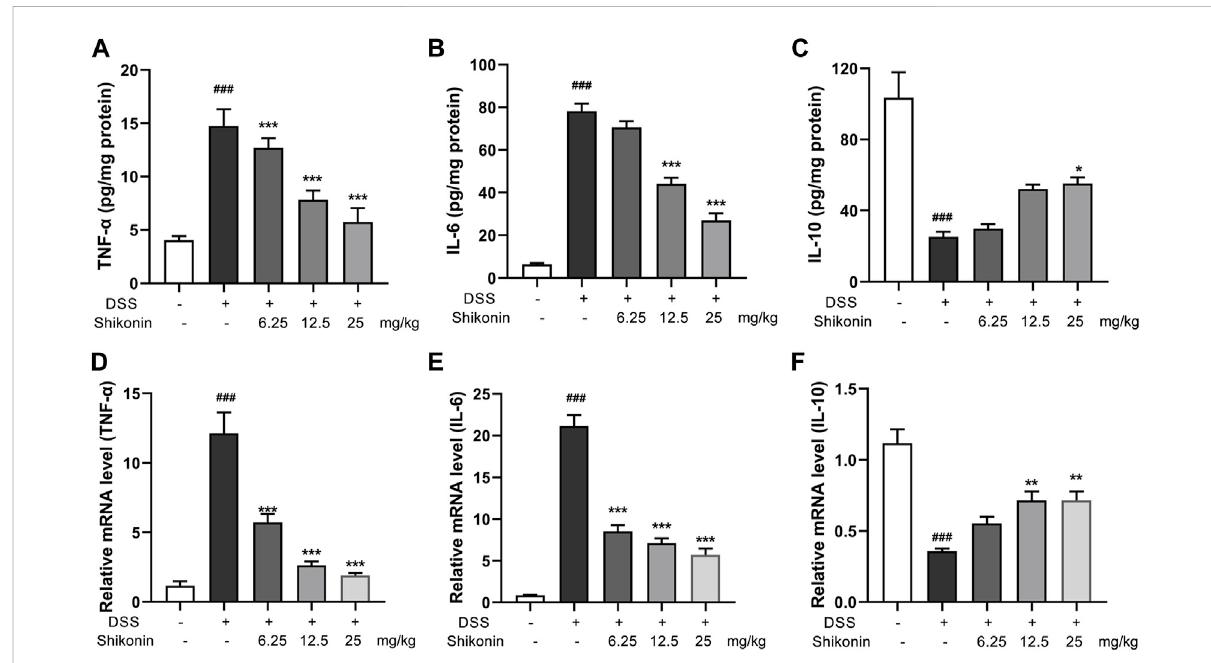
FIGURE 3 Effects of Shikonin on colon cytokines in DSS-induced mice colitis. Colon in fl ammatory factors, TNF- α (A) , IL-6 (B) , IL-10 (C) in the colon of acutecolitismiceweredeterminedbyELISA.RelativemRNAexpressionofTNF- α (D) ,IL-6 (E) ,IL-10 (F) inthecolonwereevaluatedbyRT-qPCR.Data areshownasthemean±SD, n =5 – 8.### p < 0.001,comparedtothecontrolgroup.* p < 0.05,** p < 0.01,*** p <